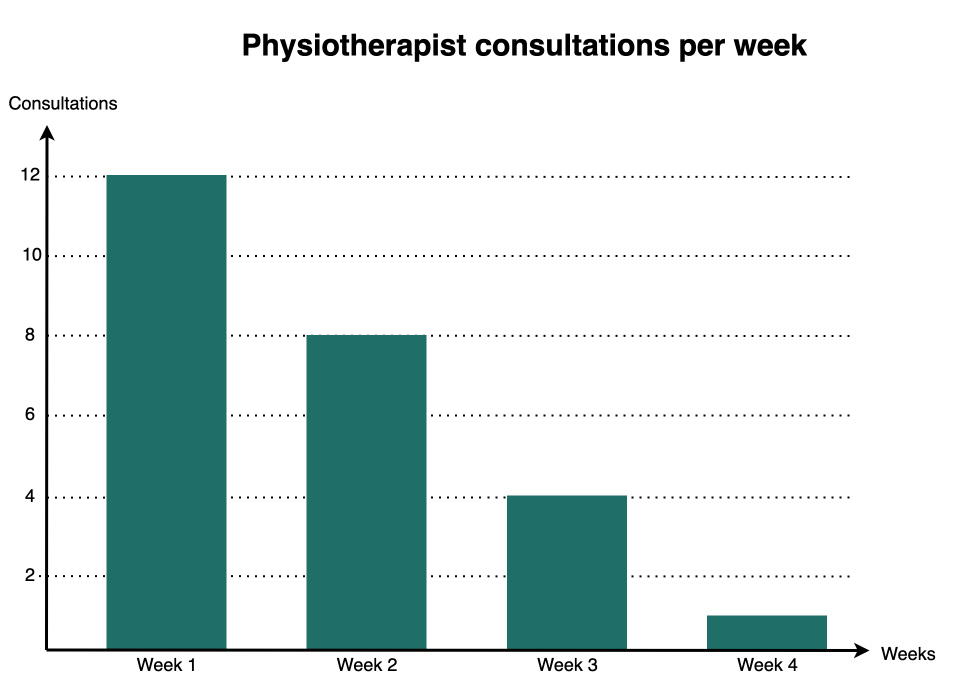
Figure 9. Physiotherapist consultations per week.